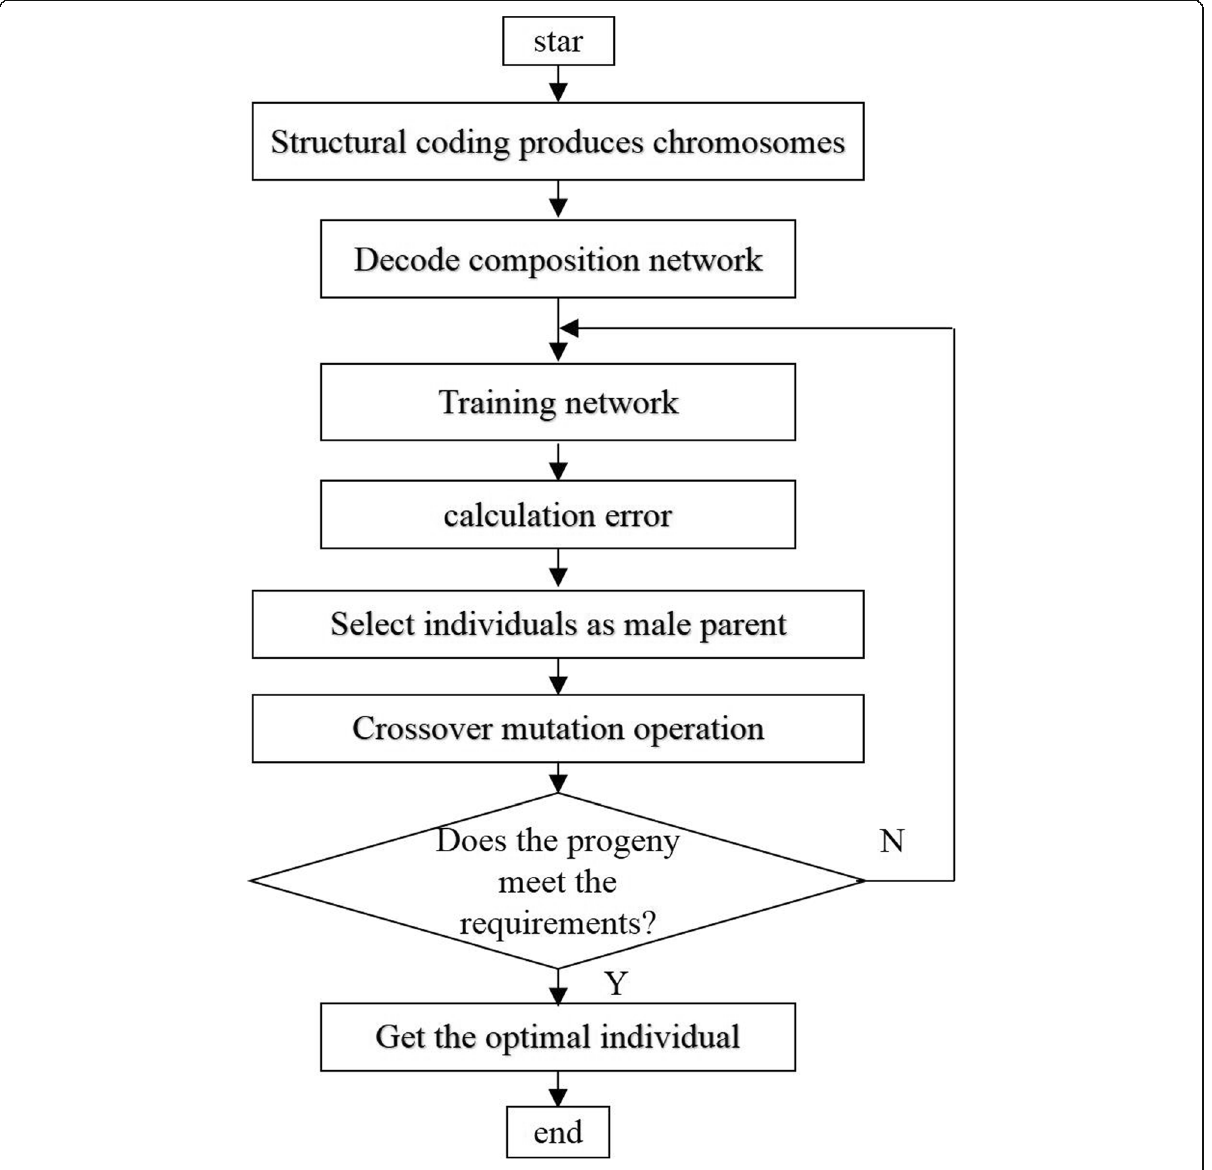
Fig. 5 Intelligent diagnosis flow chart of short children based on after decoding. The initial weights of the neural network The genetic algorithm is used to optimize the structure are 1 for learning and training. The difference between the of BP neural network. The first step is to preprocess coding expected output value and the actual output value of each and decoding. After determining the number and number coding corresponds to the difference between the expected of nodes in the hidden layer, the chromosomes are ran- output value and the actual output value. The cycle of the domly generated to form corresponding neural networks Table 1 Comparison between predicted and actual values Particular Predicted value (%) Real value (%) Relative error year